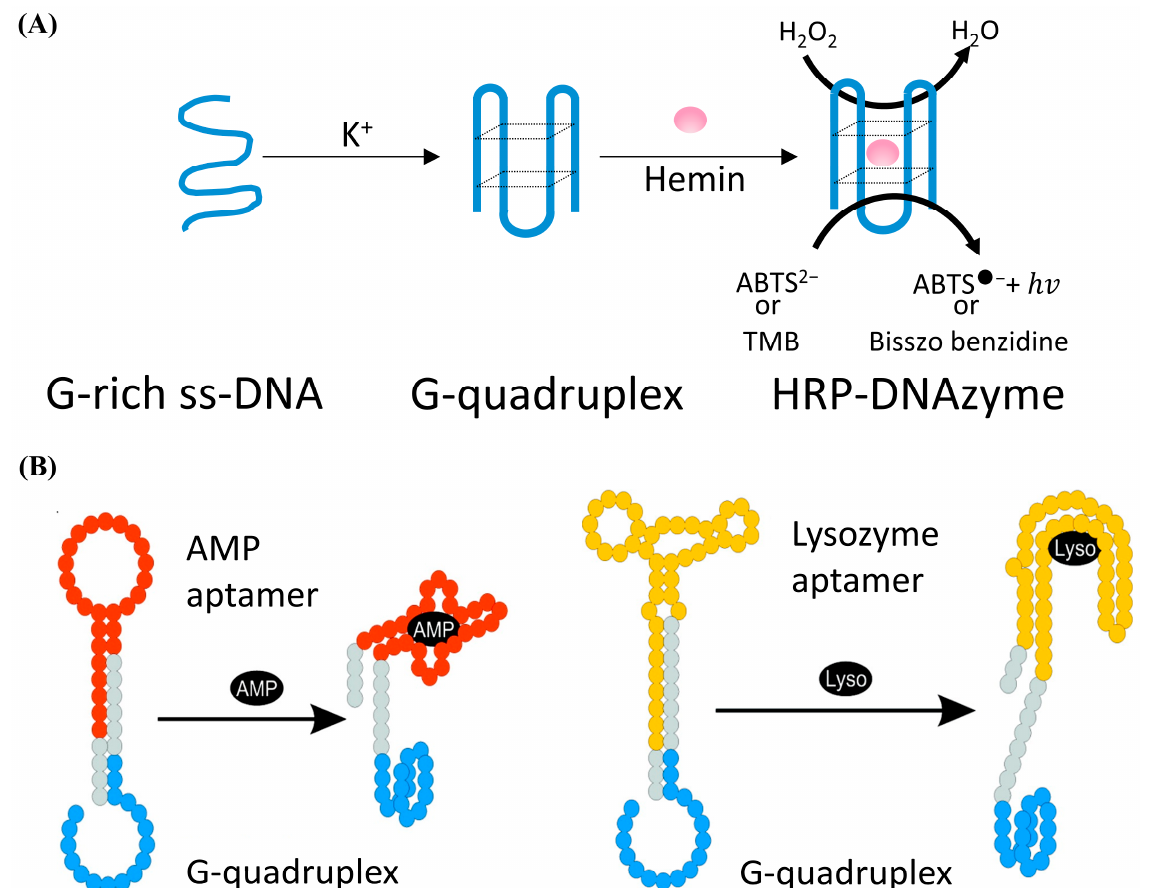
Figure 5. ( A ) Schematic of the form and the function of the HRP-DNAzyme. ( B ) Schematic analysis of adenosine monophosphate (AMP) or lysozyme (Lyso) by the aptamer—DNAzyme hairpin structure; reprinted (adapted) with permission from [106]. Copyright (2009) American Chemical Society.